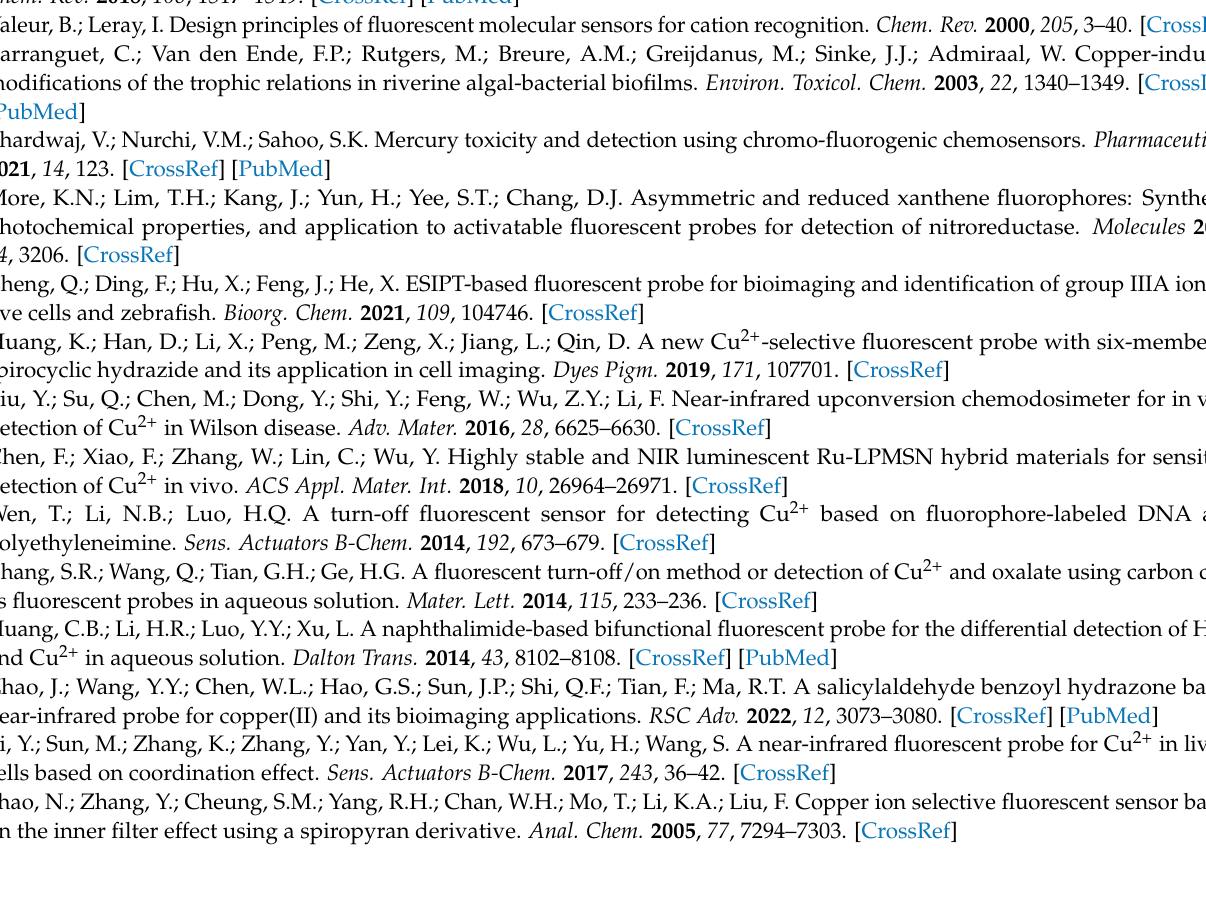
NMR spectrum of P; Figure S3: 13 C NMR spectrum of P; Figure S4: MS spectra of P1; Figure S5: Fluo- rescence interfering experiment; Figure S6: Job’s plot for P and Cu 2+ ; Figure S7: Benesi–Hildebrand plot between P and Cu 2+ . Figure S8: MS spectra of P-Cu 2+ ; Figure S9: MTT